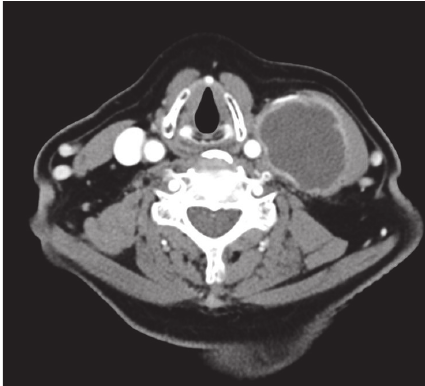
Figure 2: Computed tomography showing a 3.3 × 5.6 cm sized thick-walled cystic lesion.